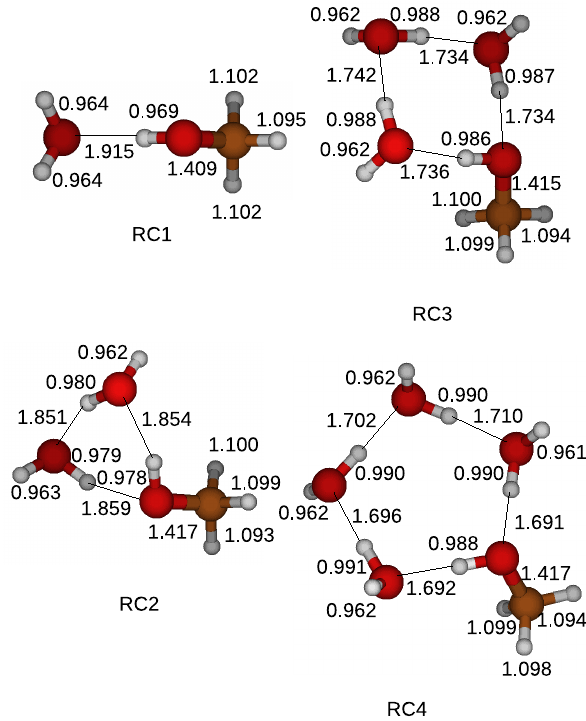
OH and H O molecules. 3 2 O 2